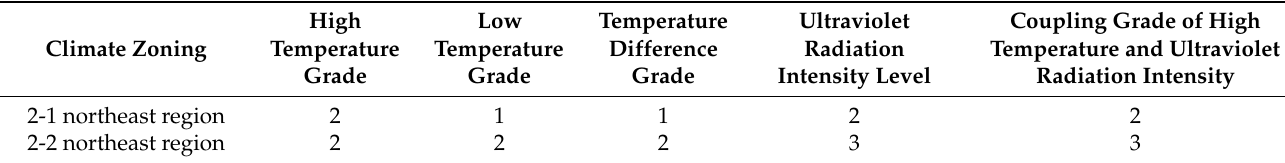
Table 12. Climatic element grades in Northeast